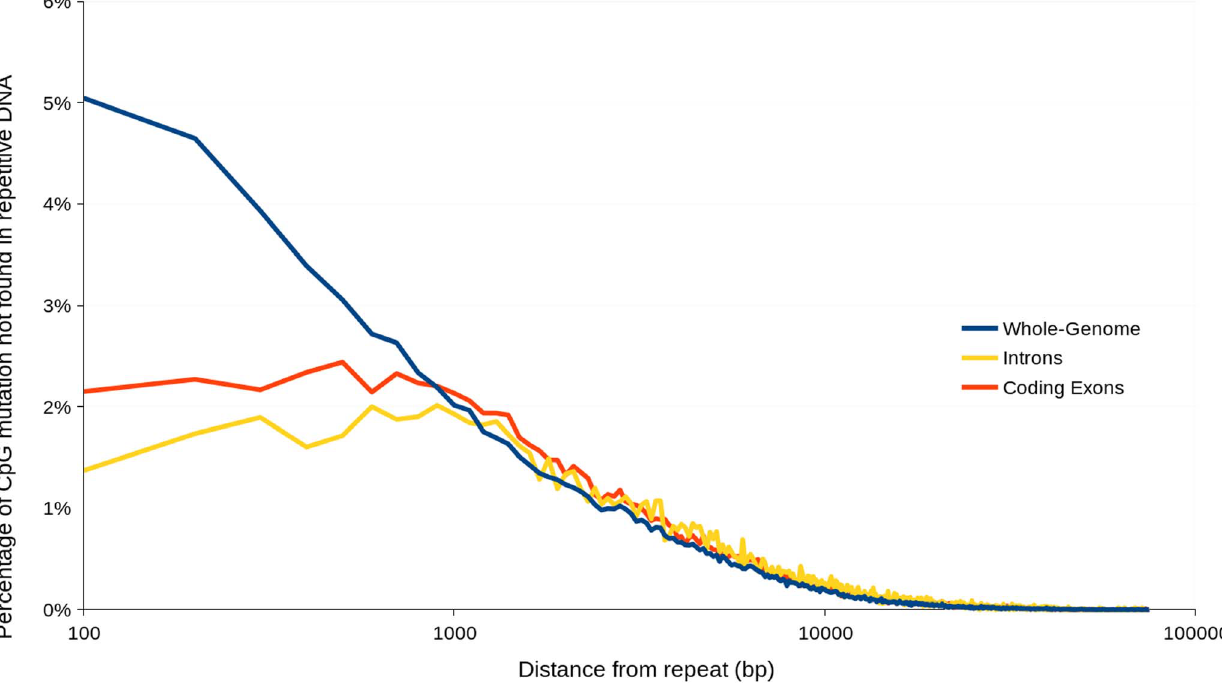
Figure 6. Percentage of heterozygous CpG « TpG mutations not occurring in repetitive DNA versus distance from nearest repetitive DNA region. Percentage values were calculated based on mutations contained within incremental distance ranges of 100 bp. doi:10.1371/journal.pgen.1004281.g006 PLOS Genetics | www.plosgenetics.org 9 May 2014 | Volume 10 | Issue 5 |